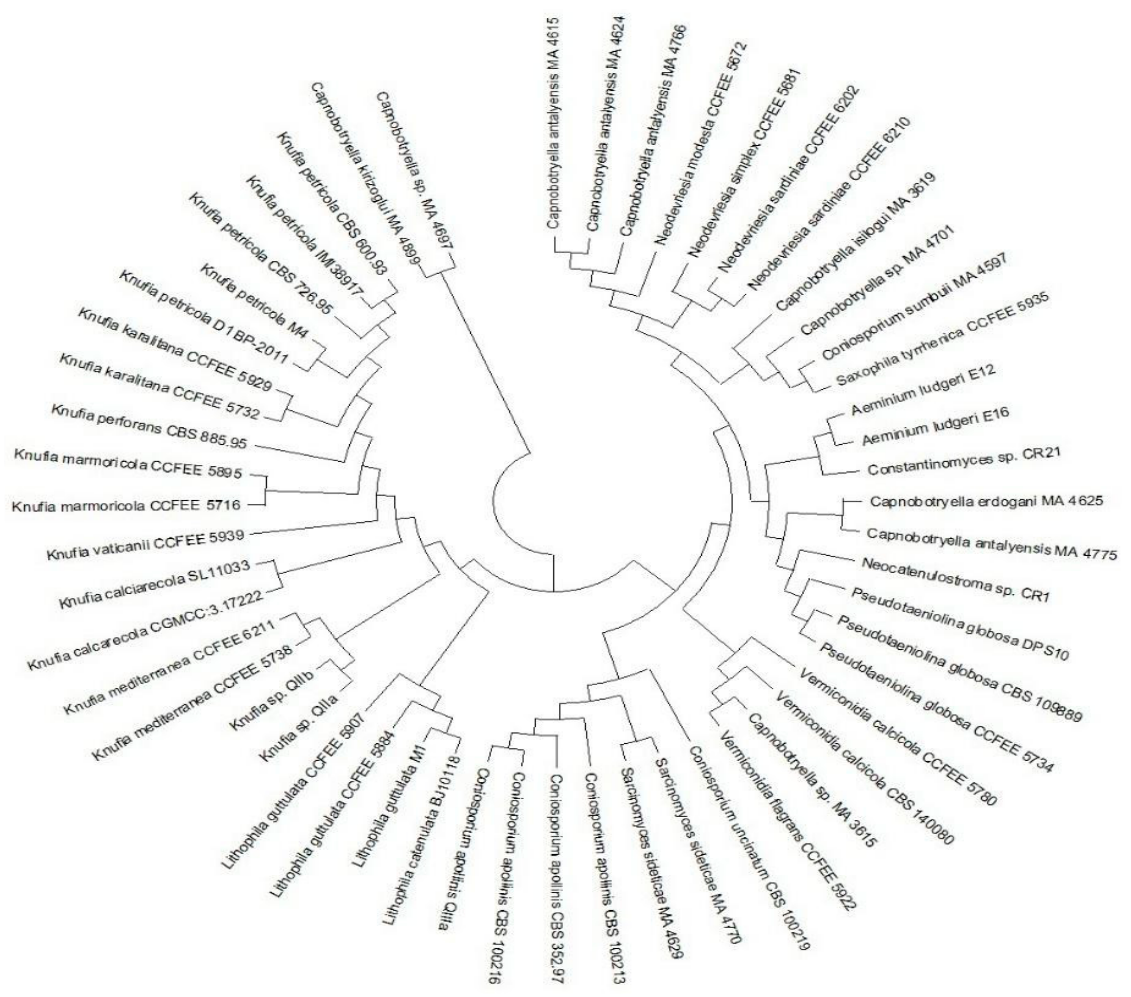
Figure 3. Phylogenetic tree (Neighbour-joining, Kimura two-parameters) showing the genetic diver- gence among ITS rDNA sequences of meristematic black fungi retrieved from GenBank database (https://www.ncbi.nlm.nih.gov/nucleotide accessed on 14 February 2022) and listed in Table 2. Table 2. ITS rDNA sequences of representative MCF isolated from stone monuments aligned in Figure 3.